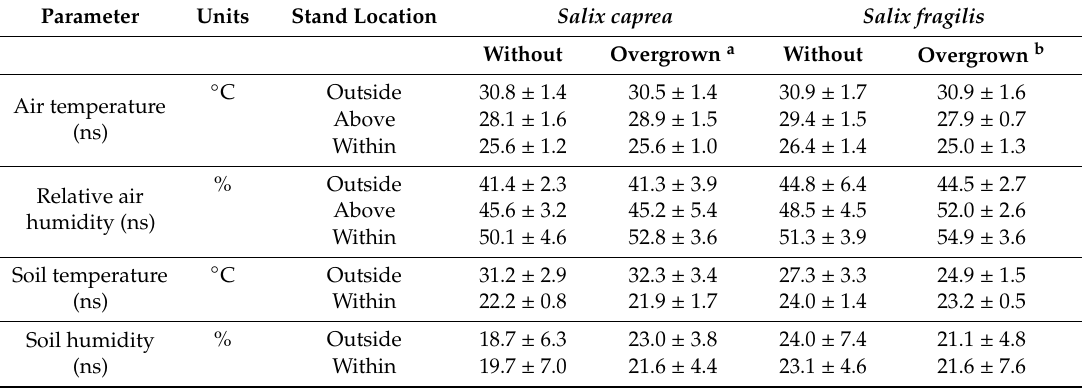
Figure 1. Relative solar radiation levels at the different wavelengths for the willow canopies. The full radiation was measured about 1 m outside the stand canopy, and the radiation within the stand canopy was measured at 1 m above the ground and at ~20 cm within the canopy, for the stands of S. fragilis without ( Salix fragilis ) and overgrown by P. quinquefolia ( Salix fragilis B ), and for those of S. caprea without ( Salix caprea ) and overgrown by E. lobata ( Salix caprea B ). Table 1. Selected physical parameters measured for the willow stands without and overgrown by the two vines. These micro-locations for the air parameters were outside the stand canopy (about 1 m from the canopy), directly above the stand canopy (at the surface of the tree canopy), and 1 m from the ground at a point positioned about 20 cm within the stand canopy. For the soil parameters, they were about 1 m outside of the stand and between the trees within the